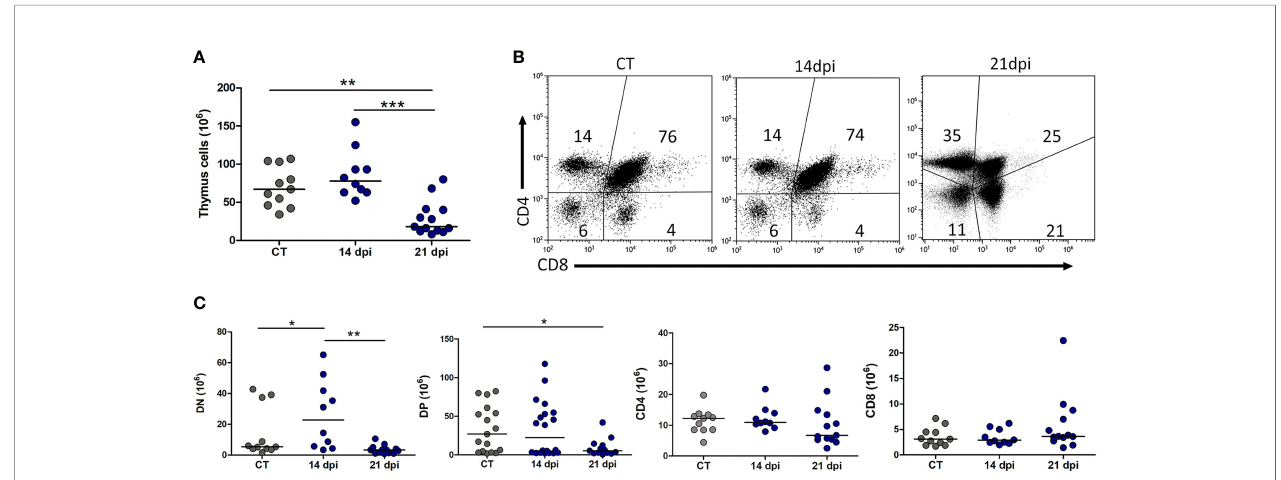
FIGURE 5 | Progressive thymic atrophy with CD4 + CD8 + thymocyte depletion in mice subjected to Trypanosoma cruzi oral acute infection. (A) Progressive decrease in total thymocyte numbers. (B) CD4/CD8-de fi ned cyto fl uorometric dot plots revealing progressive loss in the relative numbers of CD4 + CD8 + double-positive thymocyte subset. The data are representative of 2 experiments with 3 – 5 animals per group at 14 dpi and 2 independent experiments with 2 – 5 animals per analysis at 21 dpi. (C) Absolute numbers of each CD4/CD8 cell. Statistical differences were ascertained with the non-parametric, Kruskal – Wallis ANOVA test with Dunn ’ s multiple comparison test. * p < 0.05, ** p < 0.001, *** p <